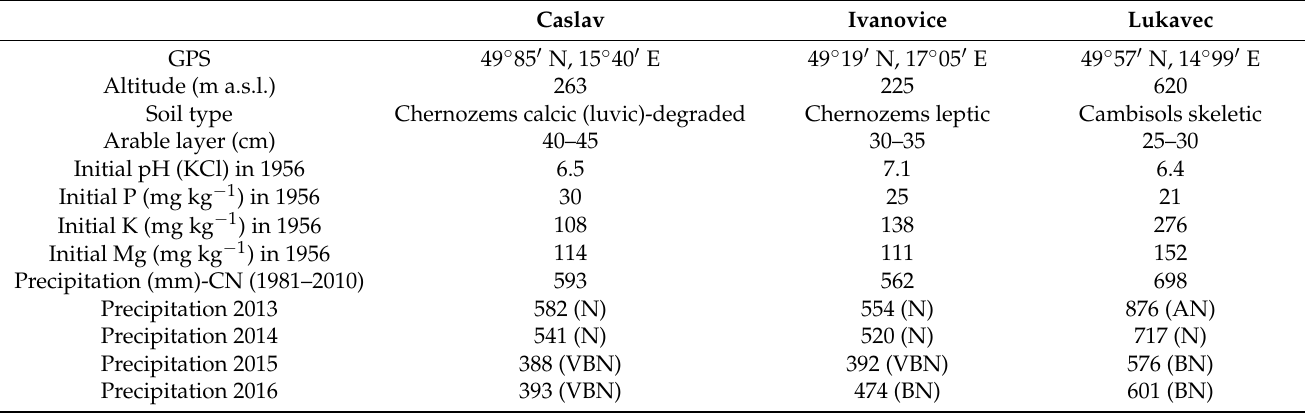
Table 1. The basic description of the experimental localities (Caslav, Ivanovice, Lukavec) with weather conditions in individual years (2013–2016) compared with the climate normal (CN; 1981–2010). The evaluation was done according to [38]. The initial soil concentrations of P were analyzed using the Egn é r-Riehm extraction method. The initial soil concentrations of K and Mg were analyzed using the Schachtschabel extraction